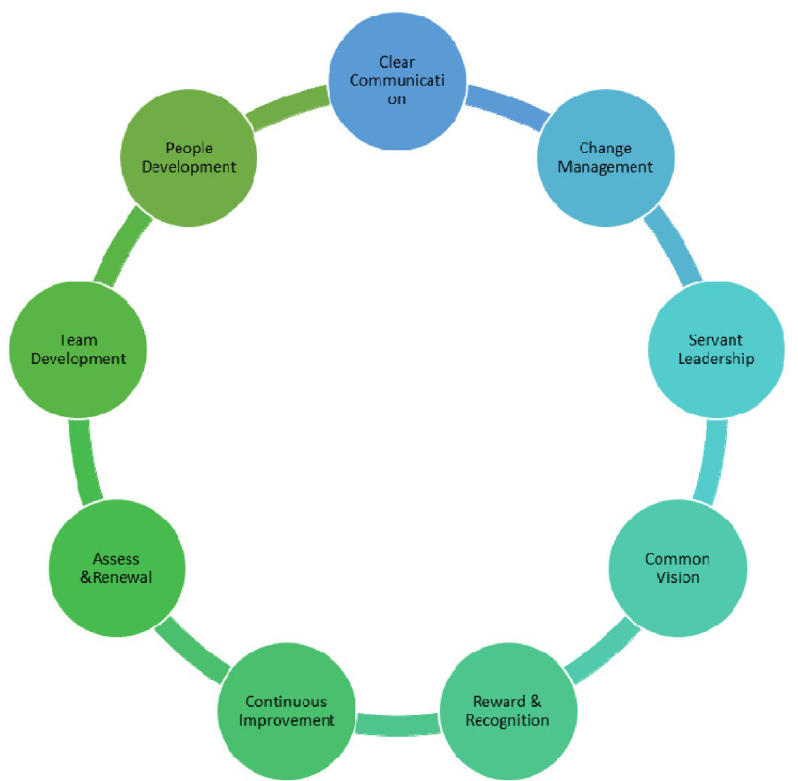
Figure 13. Performing Elements